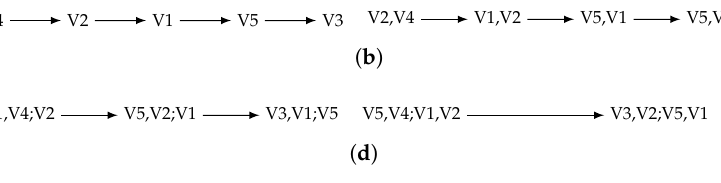
Figure 7. Tau D-vine of the volume variable. ( a ) Tree 1. ( b ) Tree 2. ( c ) Tree 3. ( d ) Tree 4. Table 4. Comparison between the different Vine structures for the volume variable. R-N, K-Tau and All-G stand for Reduced-Network, Kendall’s τ and All-Gauss vines,